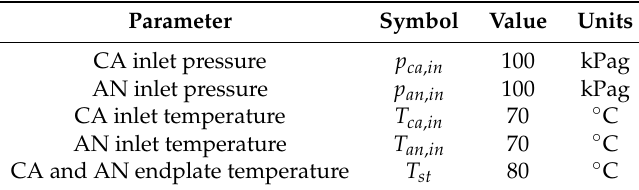
Table A1. Greenlight Innovation G60 operating parameters.